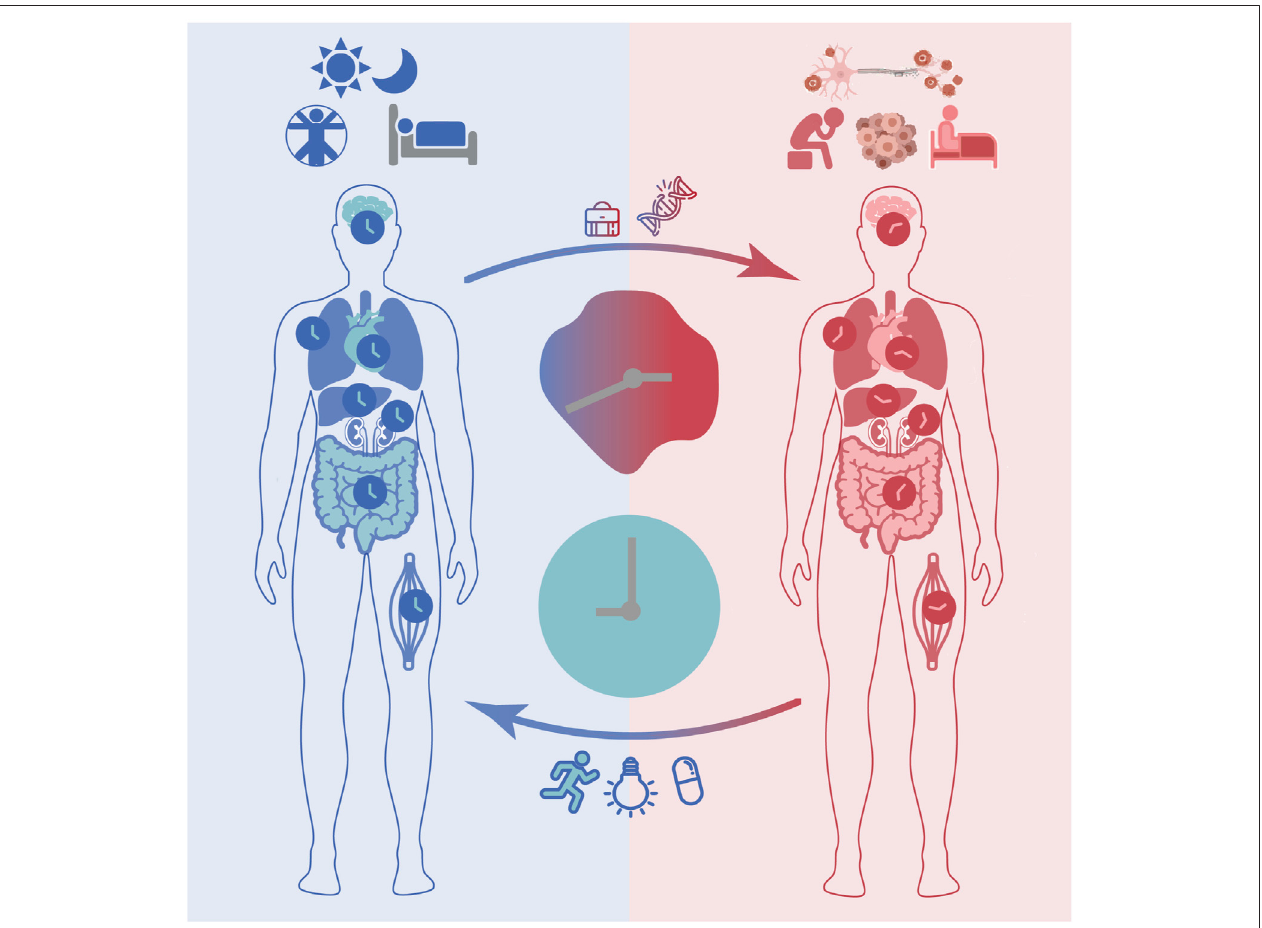
FIGURE 1 | The circadian clock impacts health and disease. In response to environmental cues such as daily light/dark cycles, the master clock in the suprachiasmatic nucleus(SCN) andperipheralclocksaresynchronized throughcomplexroutesofneuronaland hormonal networks.Properfunctioningofthecircadian clock ensures correct timing of physiology and behaviour (e.g., sleep/wake cycles) and contributes to maintaining a healthy life. Disruptions of circadian rhythms may occur due to genetic factors or life style determinantssuch as long-term shift work and are associated with various health complications including mood and sleep disorders, neurodegenerativediseasesand cancer.Clinical interventions aimingatrestoring circadianrhythms and minimizingtheconsequences ofcircadiandisruption (e.g.,brightlighttherapy,physicalexercise),aswellastargetingtreatmentoptimizationviatimingtheadministrationofdrugcompounds(i.e.,chronotherapy)arecurrently being